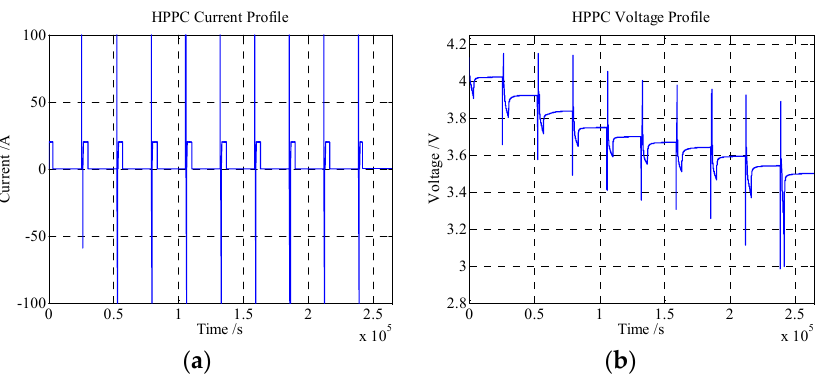
Figure 3. HPPC test ( a ) Current profile; ( b ) Voltage response